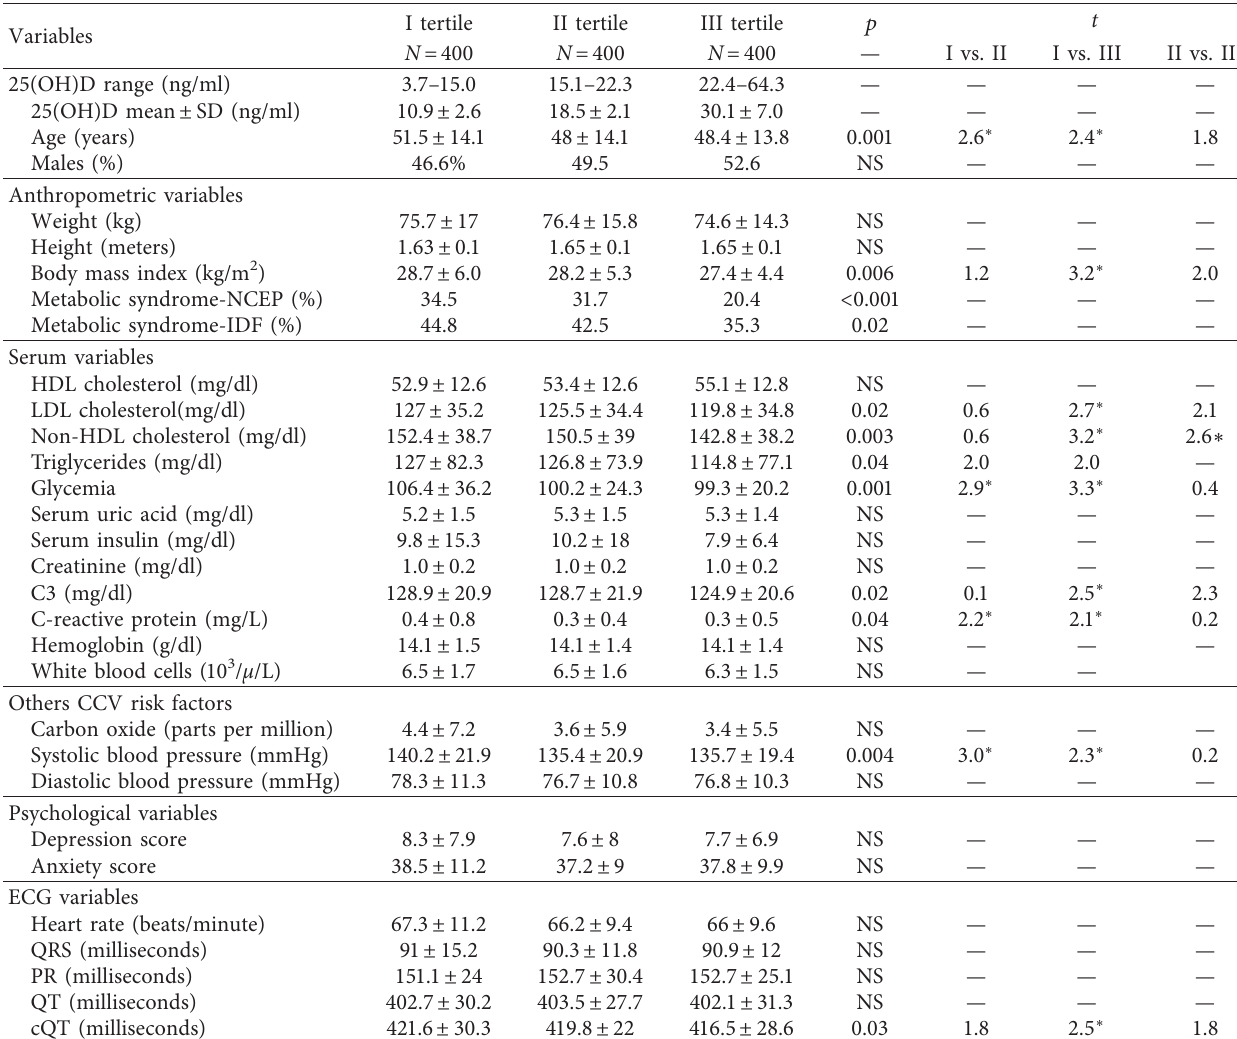
Table 4: Differences of 25(OH)D tertiles in demographical, clinical, and laboratory